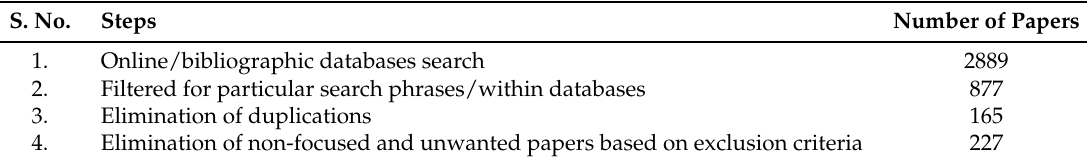
Table 2. Paper count during various steps of data acquisition.